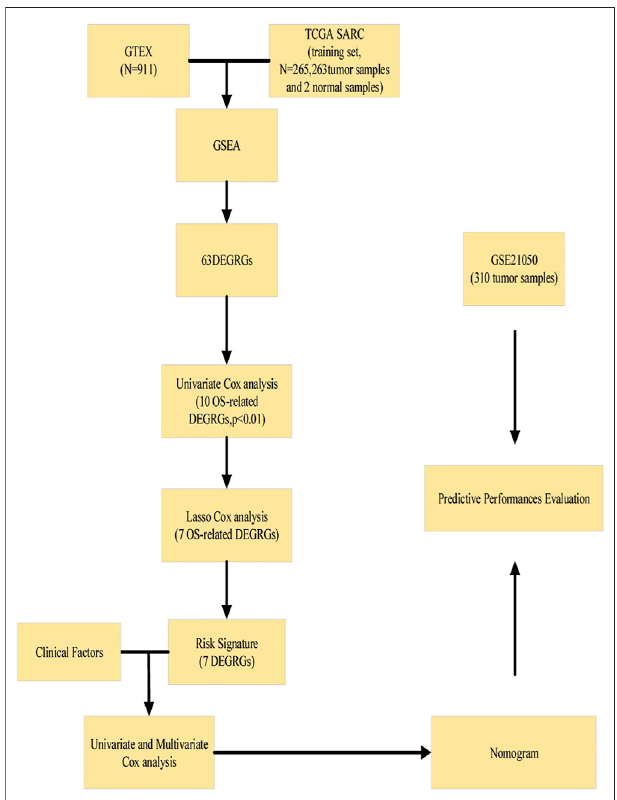
FIGURE1| Flowchartofconstructionandvalidationofthesignatureand